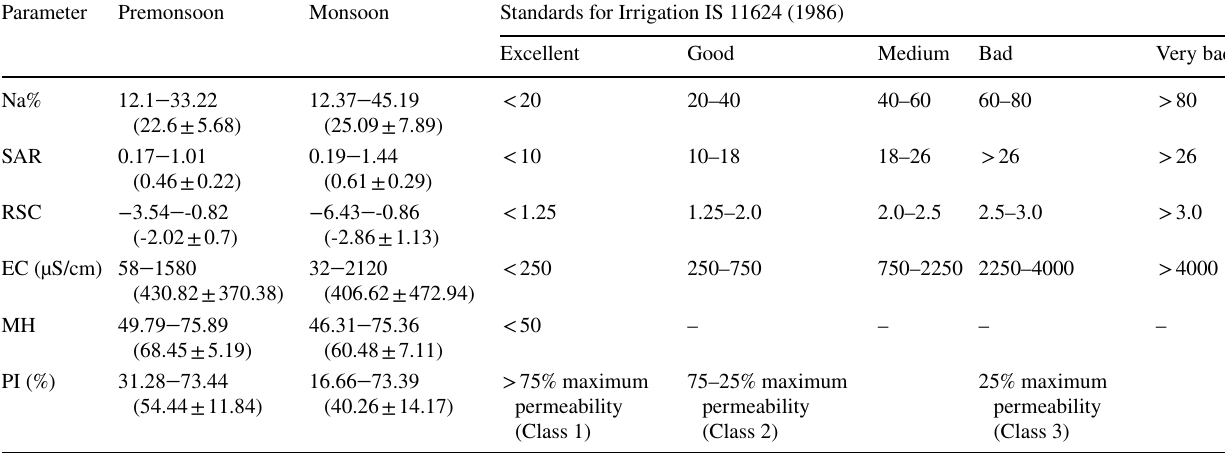
Table 9 Assessment of irrigation potential of mine water based on analysis of Na%, SAR, RSC, EC, MH and PI